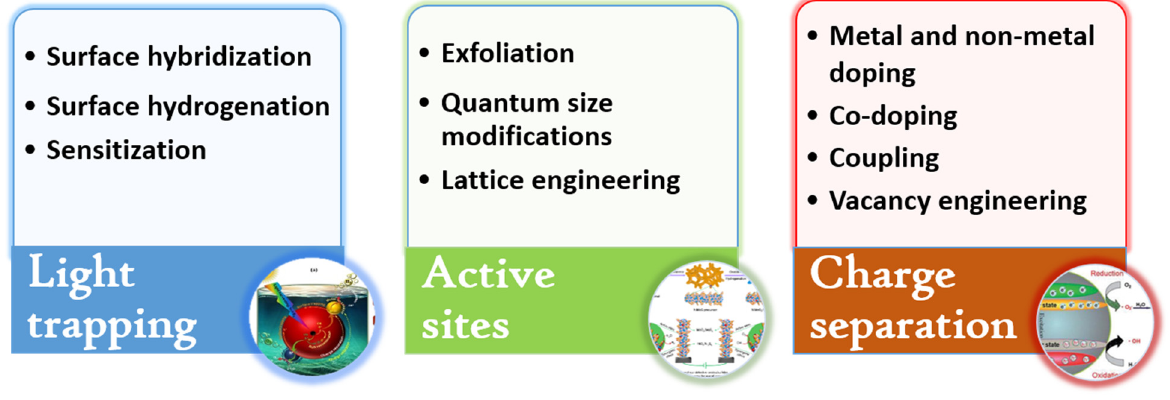
Figure 3. Types of chemical modifications in TiO 2.